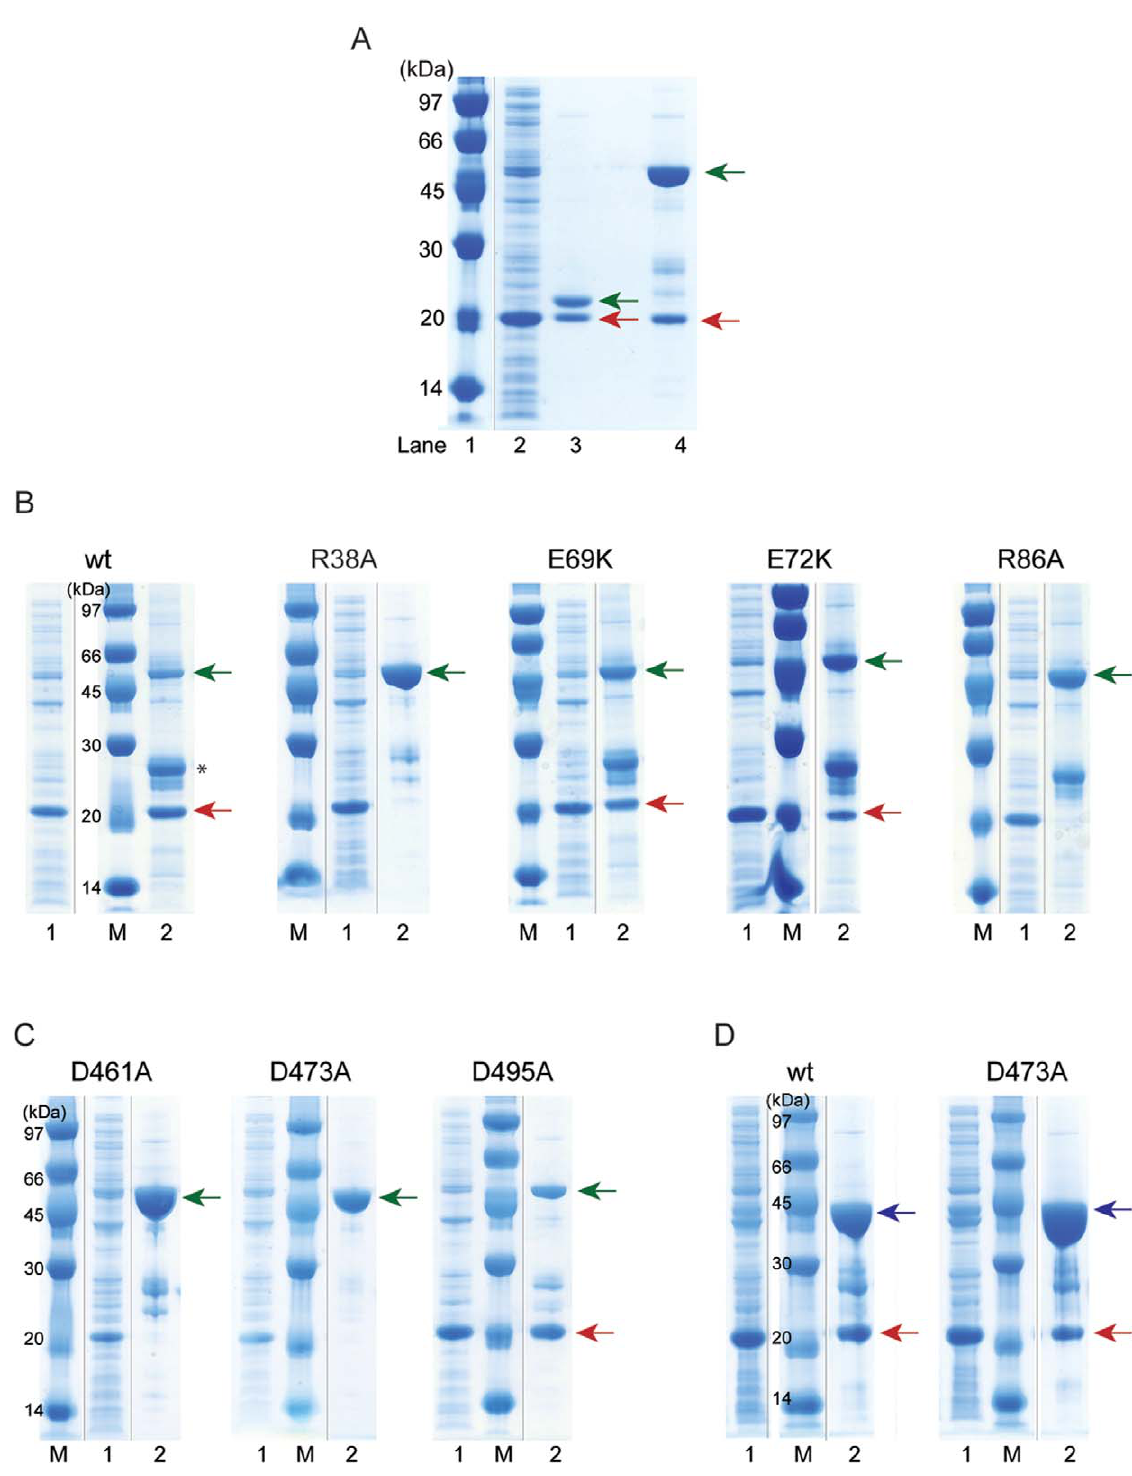
Figure 4. Complex formation between NOD2 CARDab and RIP2-CARD. (A) NOD2 CARDab with a N-terminal GST-tag and RIP2-CARD equipped with a N-terminal GB1-tag and a C-terminal His 6 -tag were co-expressed and pulled-down with glutathione sepharose beads. From left: Lane 1) Protein Marker, GE Healthcare. Lane 2) Soluble lysate. Lane 3) Bead eluate after 3C-protease cleavage. NOD2-CARDab 22.0 kDa and GB1-RIP2 CARD- His 18.6 kDa are indicated by green and red arrows, respectively. Lane 4) Supernatant bound to beads. GST-NOD2 CARDab 48.5 kDa (green) and GB1- RIP2 CARD-His 18.6 kDa (red) are indicated by arrows. (B) Effect of NOD2 CARDab single point mutations on RIP2 CARD binding. A representative cross section of the mutants tested are shown. GST-NOD2 CARDab 48.5 kDa and GB1-RIP2 CARD-His 18.6 kDa are indicated by green and red arrows, respectively. *=residual expression of GST. (C) Effect of RIP2 CARD single point mutations on NOD2 CARDab binding. A cross section of the mutants tested are shown. GST-NOD2 CARDab 48.5 kDa and GB1-RIP2 CARD-His 18.6 kDa are indicated by green and red arrows, respectively. (D) Effect of RIP2 CARD single point mutations on NOD1 CARD binding. A cross section of the mutants tested are shown. GST-NOD1 CARD 40.9 kDa (aa17–138) and GB1-RIP2 CARD-His 18.6 kDa are indicated by blue and red arrows, respectively. doi:10.1371/journal.pone.0034375.g004 PLoS ONE |